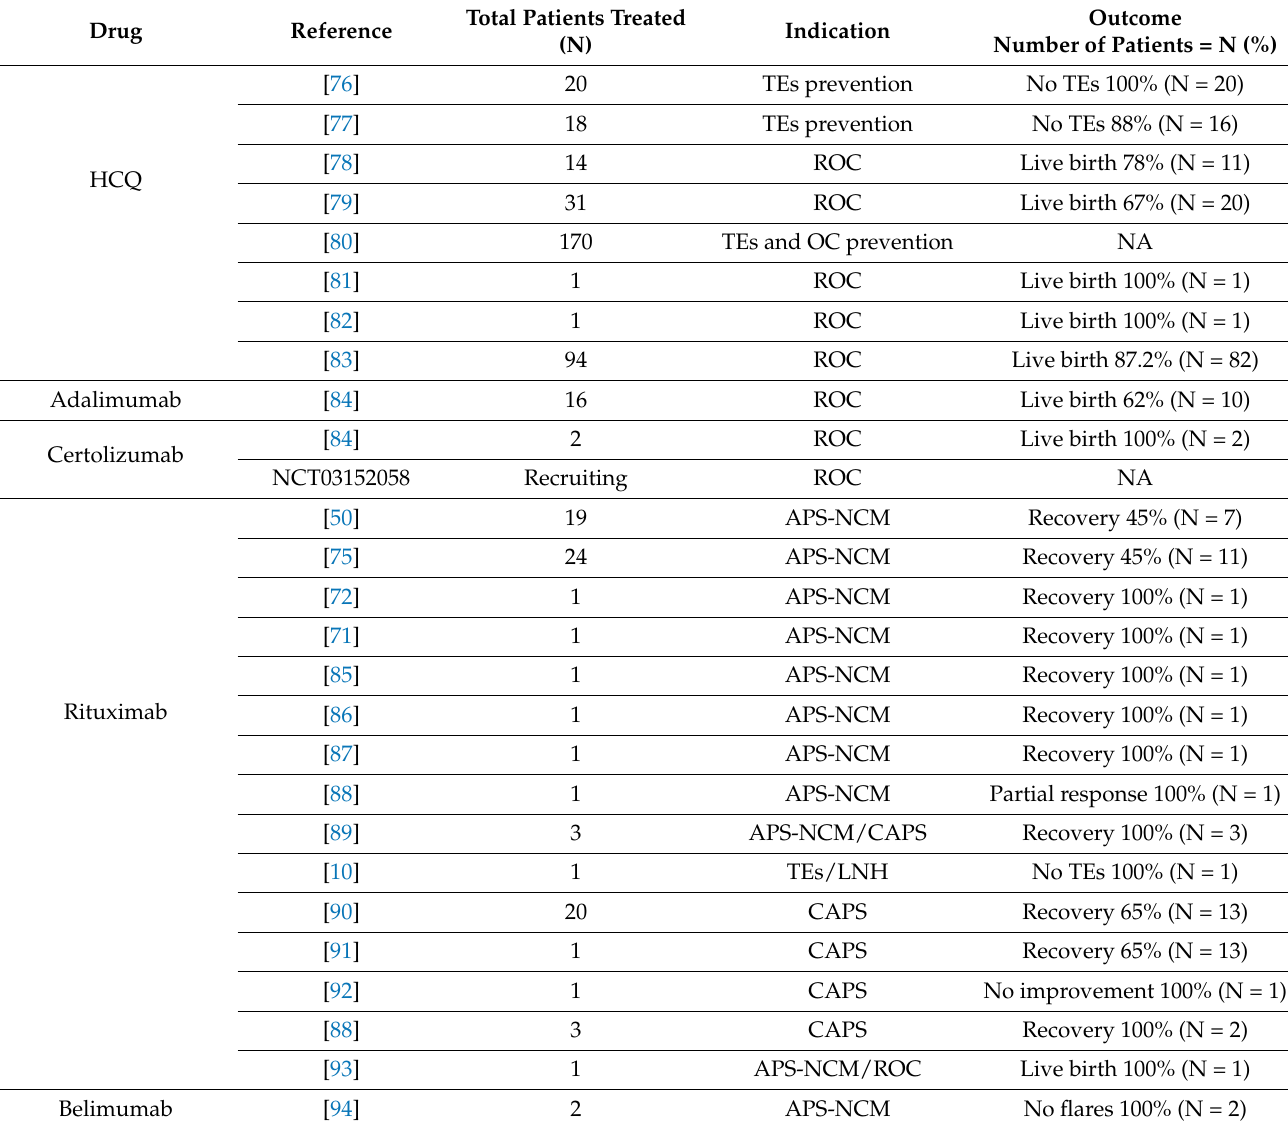
Table 1. Summary table of studies included in the present systematic literature review, total patients treated (N), clinical indication and